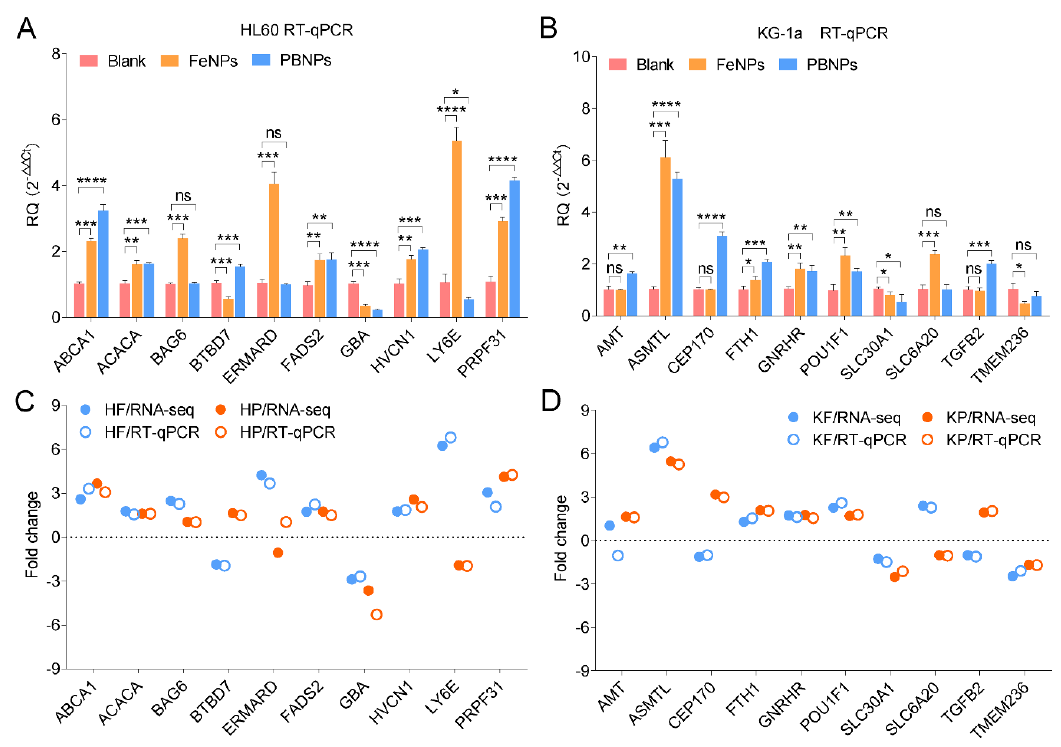
Figure 7. Validation of RNA-Seq DEGs using RT-qPCR: ( A , B ) the expression levels of 10 selected DEGs in the iron nanoparticle-treated HL60 ( A ) and KG1a ( B ) cells. All values are mean ± SD with n = 3. ns, no significance; *, p < 0.05; **, p < 0.01, ***, p < 0.001, ****, and p < 0.0001. ( C , D ) The comparison